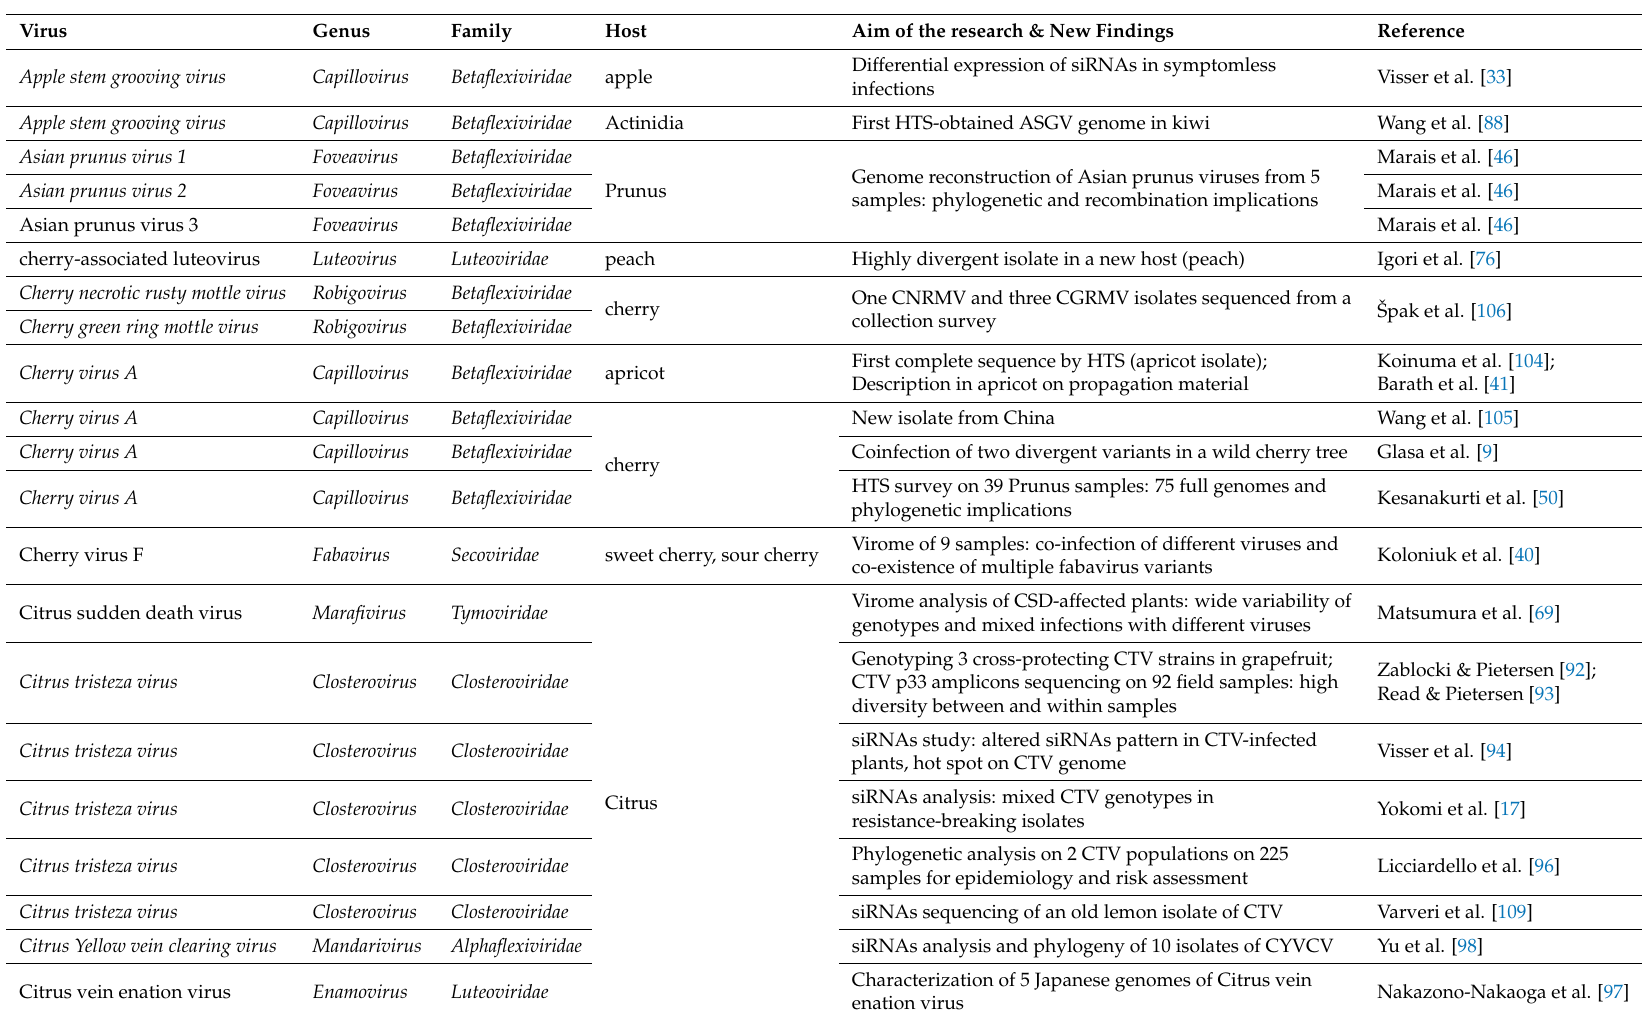
Table 3. Detection and virus genetic variability